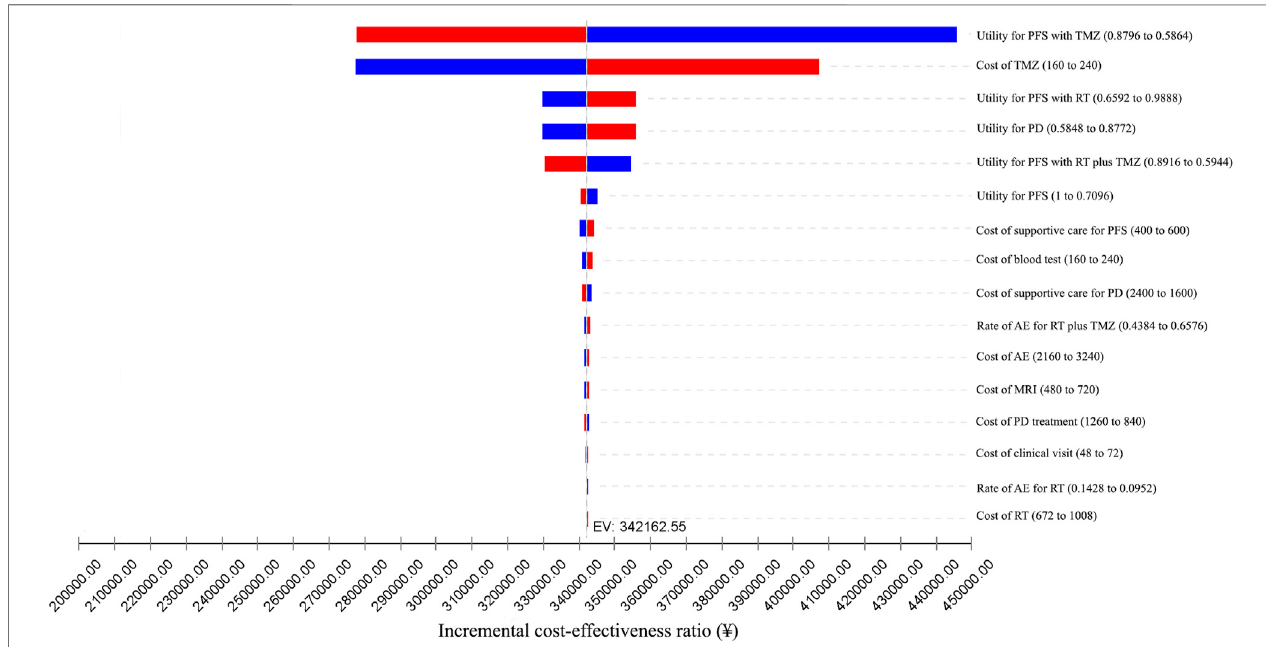
FIGURE 2 | One-way sensitivity analyses from the Chinese perspective. AE: adverse event; EV: expected value; MRI: magnetic resonance imaging; PD: progressive disease; PFS: progression-free survival; RT: radiotherapy; TMZ: temozolomide.